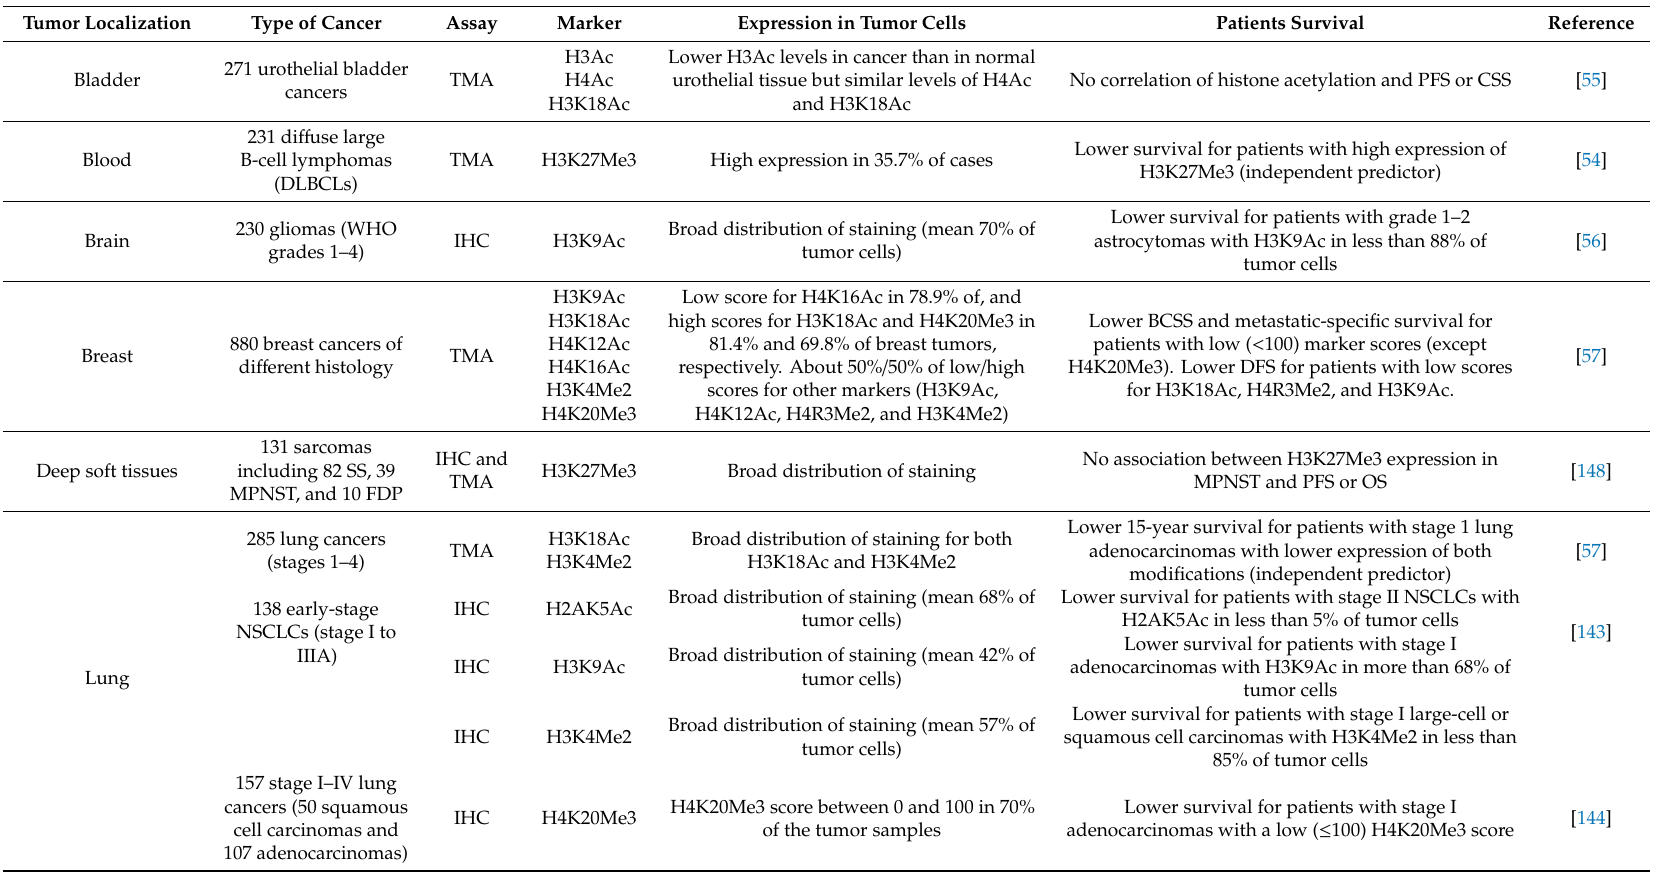
Table 2. Global histone acetylation and methylation in relation to survival of patients with